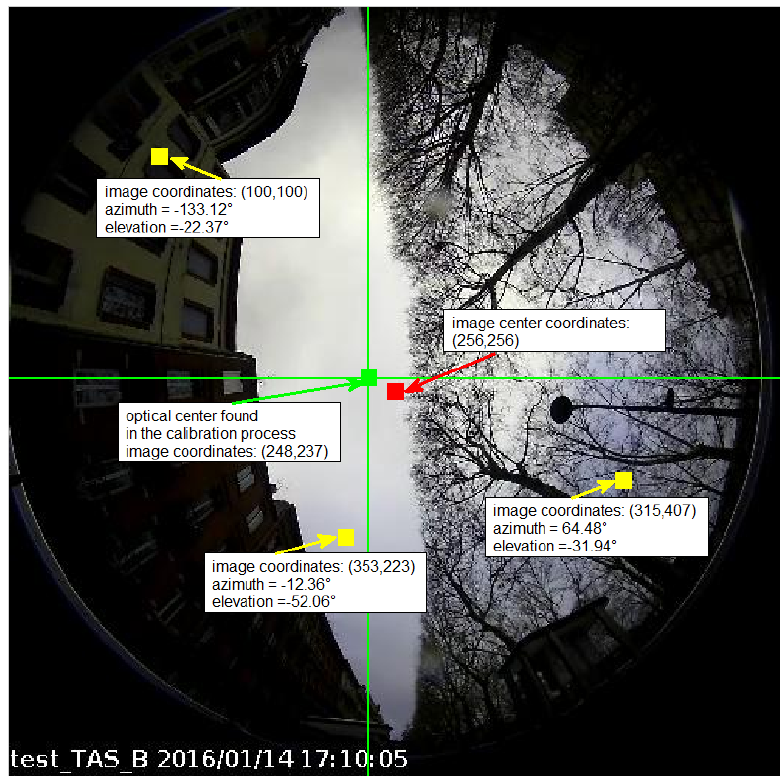
Figure 1. Examples of correspondence between spherical coordinates and image pixels. The horizontal positioning errors are computed based on the position error in the north (parallel with the ordinates’ axis) and the east (parallel with the abscissas’ axis) components. These errors are computed based on the difference between measured positions and